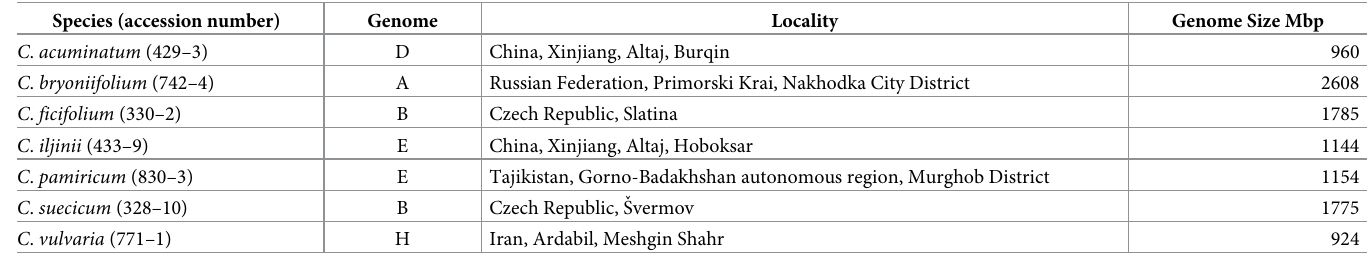
Table 1. The accessions and geographic origins of diploid Chenopodium species (2n = 2x = 18). Species (accession